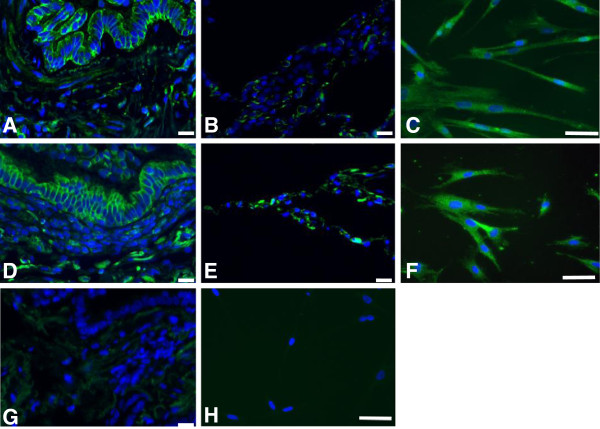
The IP receptor is expressed by epithelial cells and fibroblasts in the lung. Representative staining is shown in bronchial lung tissue (A), parencyhmal lung tissue (B), and distal lung fibroblasts in vitro (C) from control subjects and bronchial lung tissue (D), parenchymal lung tissue (E) and distal lung fibroblasts in vitro (F) from patients with COPD. Panel (G) and (H) show isotype-matched control IgG. Scale bars are indicated as 10 μm in Figure 1A, B, D, E and G and 50 μm in panel 1 C, F and H.